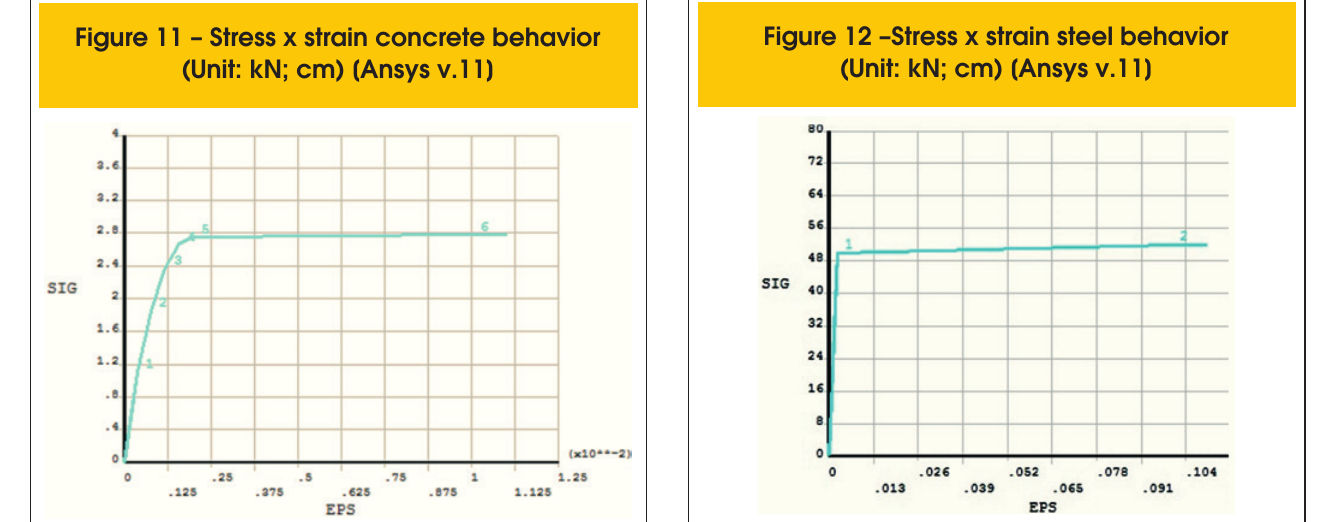
Figure 11 – Stress x strain concrete behavior (Unit: kN; cm) [Ansys v.11]